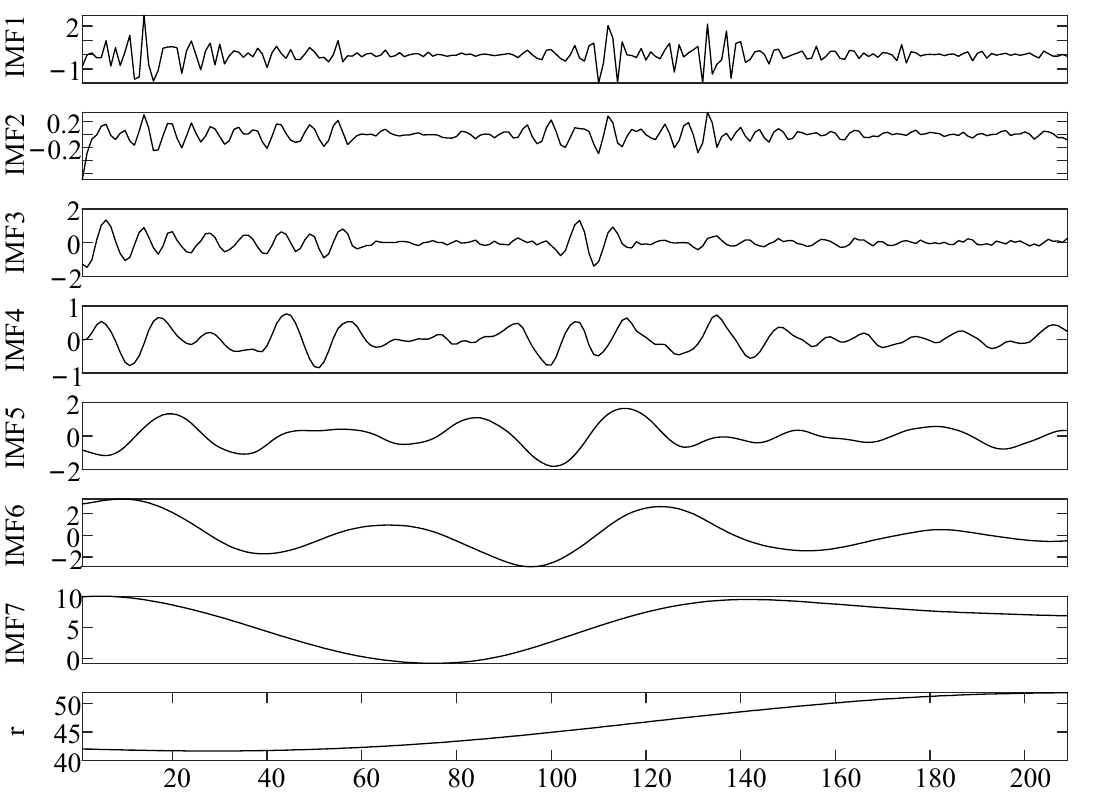
Figure 4. The decomposition result of the initial CTP for China’s national CET market.